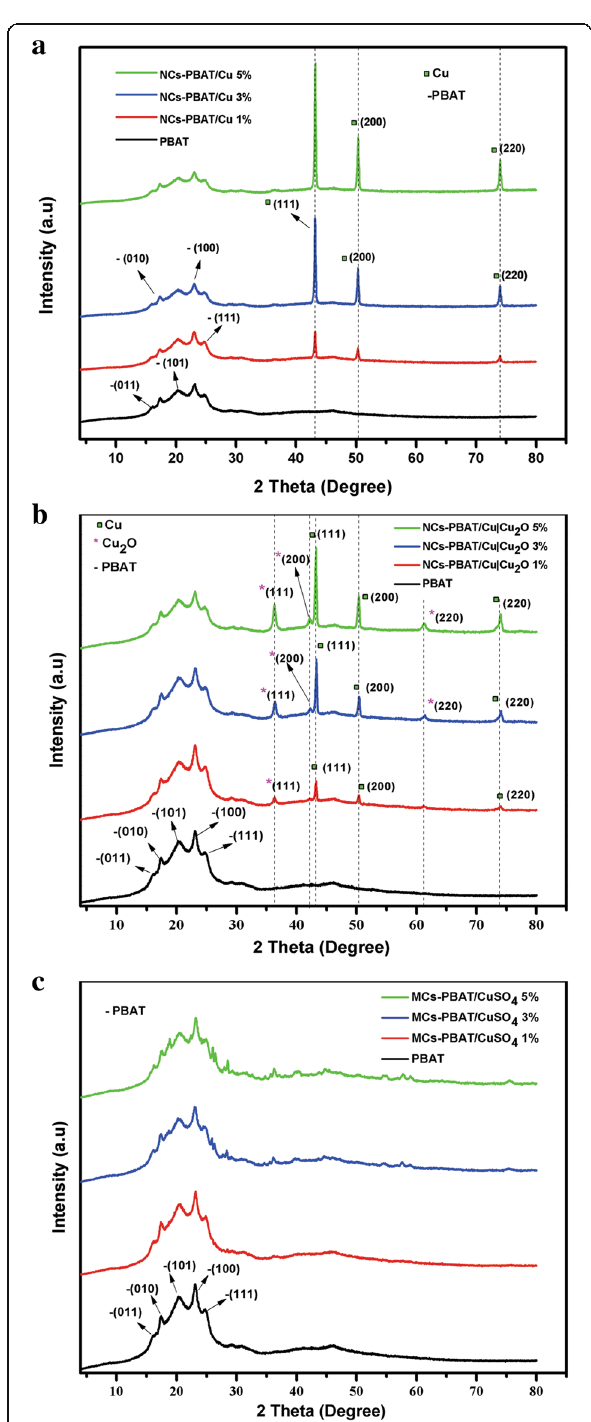
Fig. 2 Diffractogram of PBAT, NCs-PBAT/Cu, NCs-PBAT/Cu|Cu 2 O, and